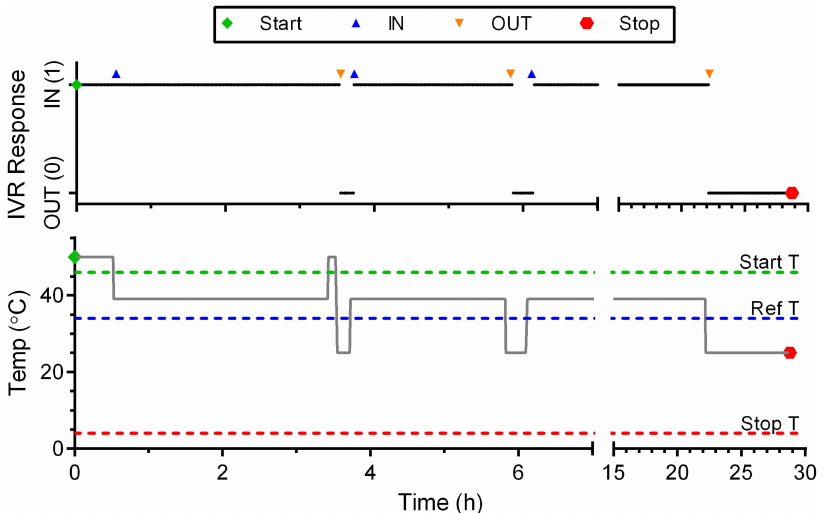
Fig 6. In Vivo Evaluation of Adherence IVR. Device responseas a function of time for a series of insertion and removalperiods in a sheepvaginalmodel. The black trace is the loggeddata (1 min logginginterval) retrieved from the device at the study conclusion.The actual time for removaland insertionevents is indicated by the symbols abovethe black trace. The gray trace shows the temperature as a function of time for the three ring dispositions: water bath (50˚C) sheepvaginaltemperature measuredat the start of the study (39˚C), and ambientlaboratorytemperature (25˚C).